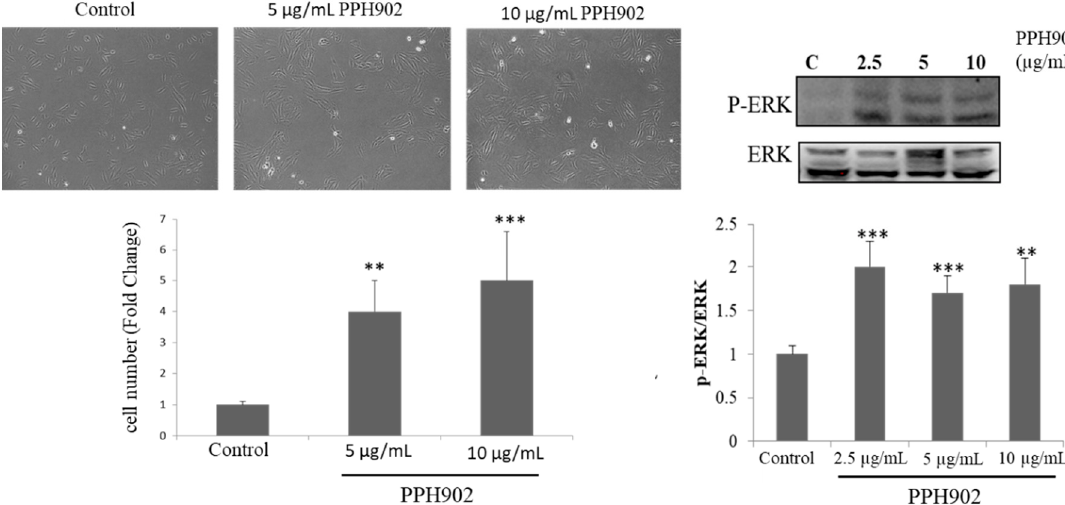
Figure 3. Effect of PPH902 on cell proliferation. Representative Western blotting shows phosphorylation levels of ERK. Treatment with PPH902 showed an increase in the C2C12 cell number. *** p < 0.001 and ** p < 0.01 indicate significant differences with respect to control group.